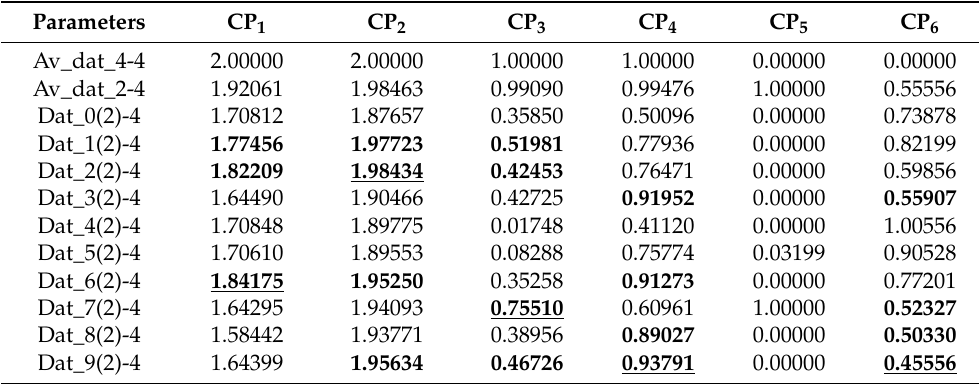
Table 3. The comparison of different pressure sensors for selection the optimal one between sensors 2. The sensor 4 is chosen as the pattern